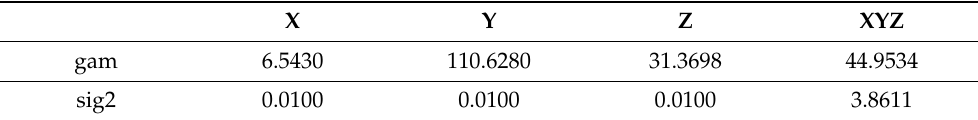
(3) The radial basis function kernel RBF_kernel was adopted as the kernel function of LSSVM, and the color moment eigenvalues of the single-axis and the three-axis magnetic flux leakage signals of the training samples were used as the input to train the LSSVM model. The algorithm is depicted in Figure